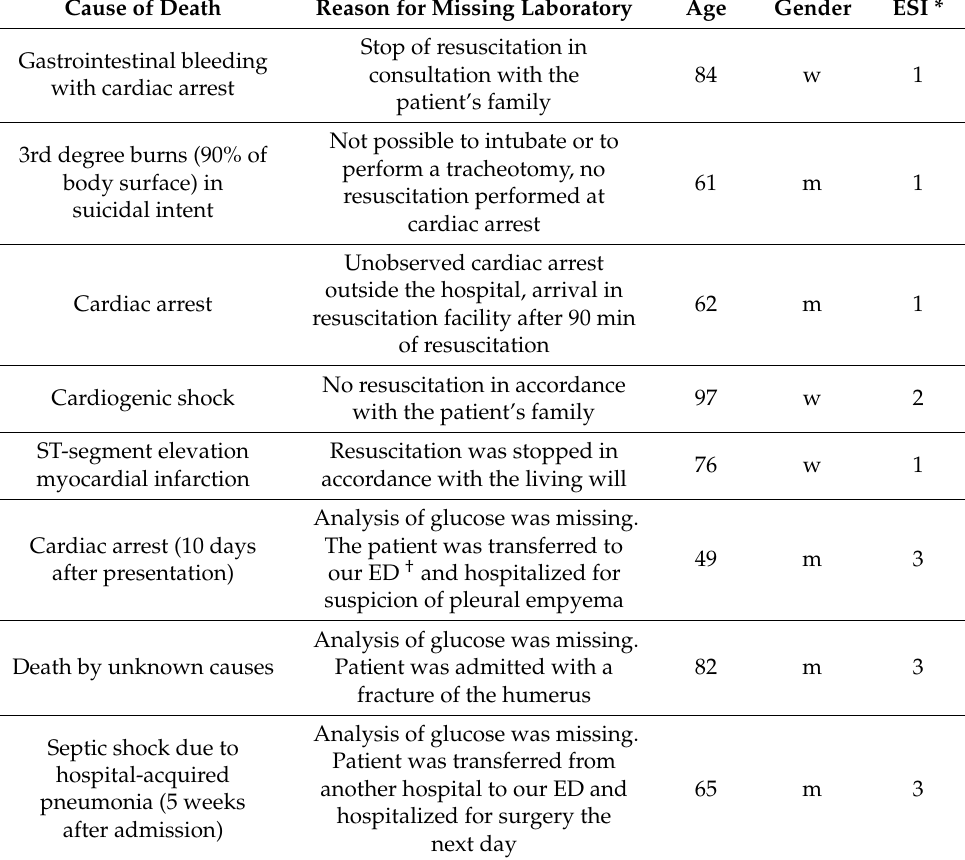
Table A1. Patients who died without laboratory